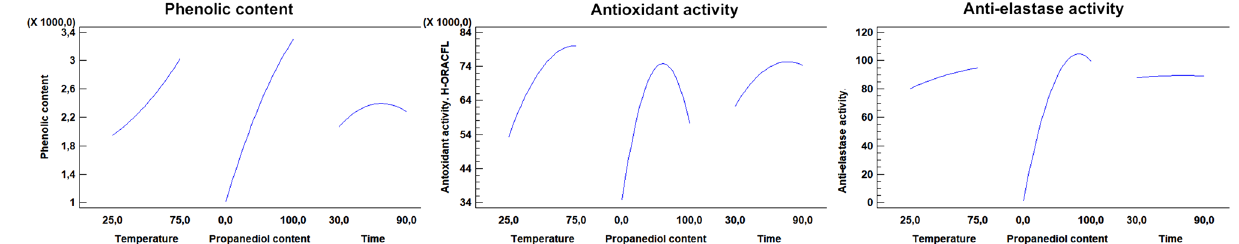
Figure 3. Phenolic content, antioxidant activity and elastase inhibition percentage evolution related to propanediol content, extraction time and extraction